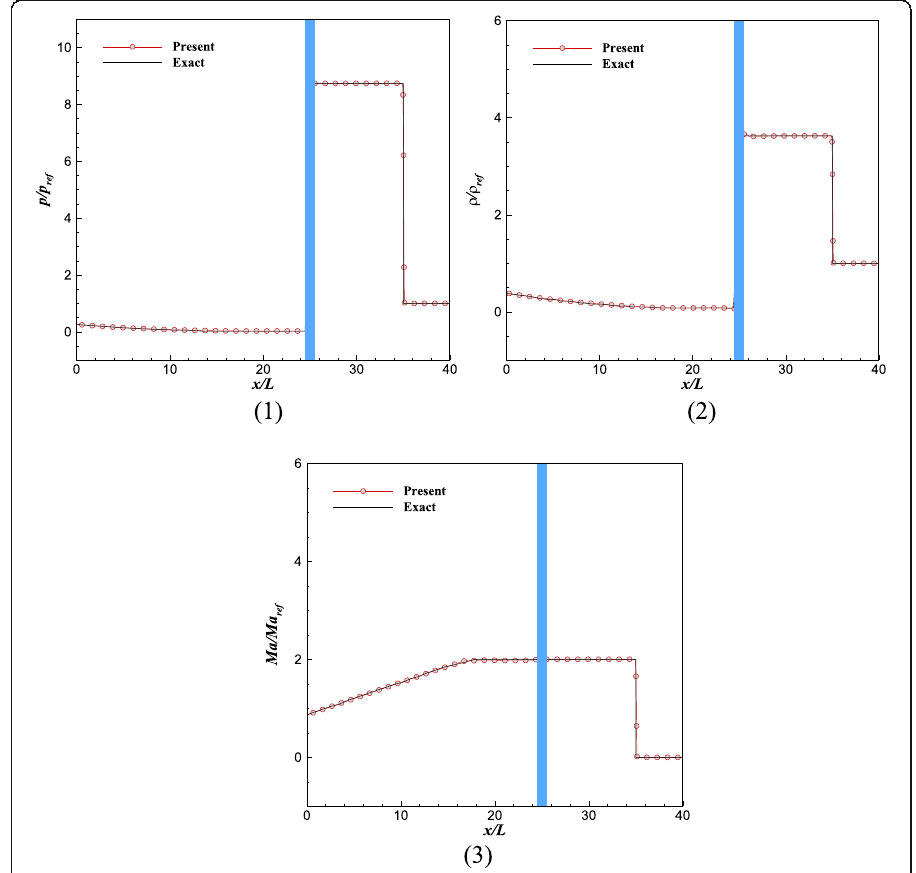
Fig. 9 Comparison of (1) pressure, (2) density and (3) Mach number distribution along x-direction with analytical results at the finest mesh Δ h = 0.05